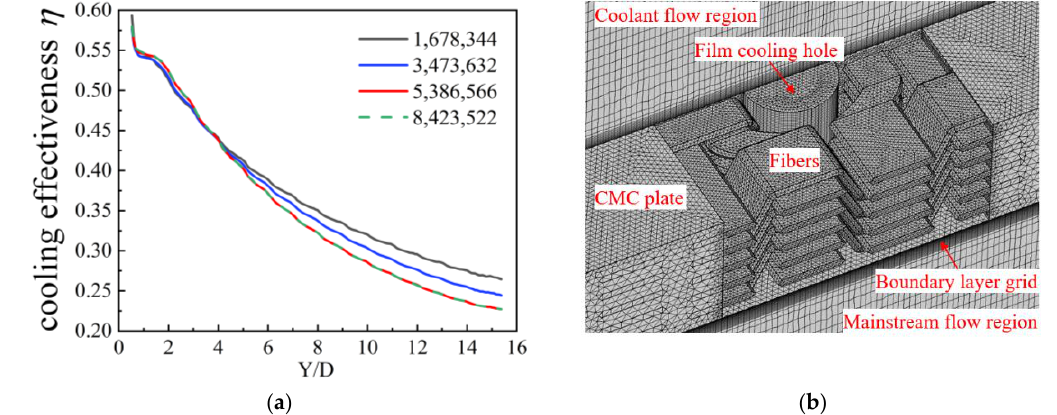
Aerospace 2021 , 8 , x Figure 8. Generation of the grid: ( a ) cooling effectiveness on line 1 with the different grid; ( b ) schematic diagram of the grid.